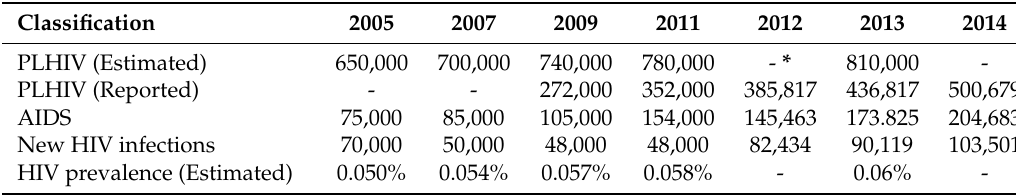
Table 2. Estimated numbers for HIV/AIDS in China